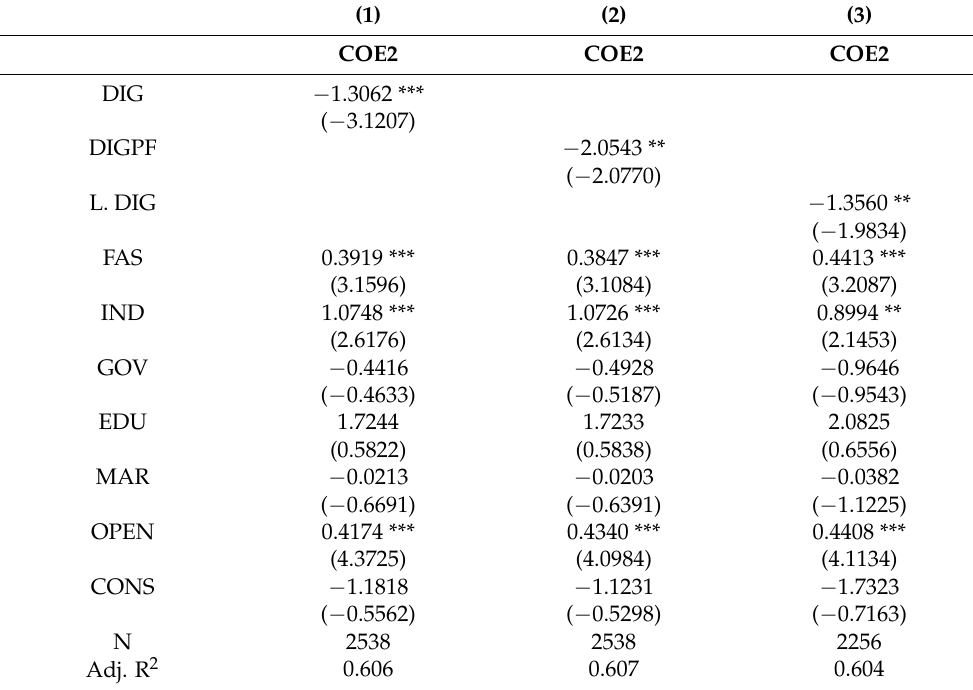
Table 6. Robustness test of changing carbon